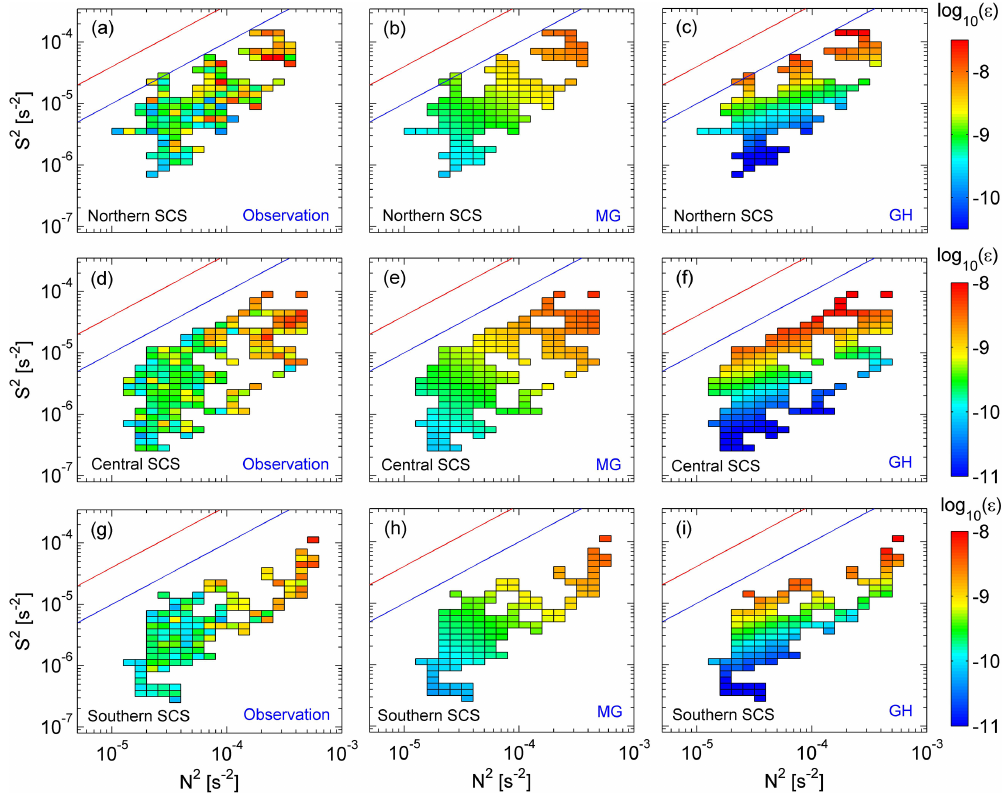
Figure 8. Dissipation rates of observation ε OB (left column), MG model ε MG (middle column), and GH model ε GH (right column) averaged in bins of 16m buoyancy frequency squared ( N 2 ) and 16m shear variance ( S 2 ) . All data affected by the surface mixed layers or bottom mixed layers were excluded. (a) – (c) show the results of the stations in the northern SCS, (d) – (f) show the results of the stations in the central SCS, and (g) – (i) show the results of the stations in the southern SCS. The boundaries of Ri = 0.25 (oblique red lines) and Ri = 1 (oblique blue lines) are shown for